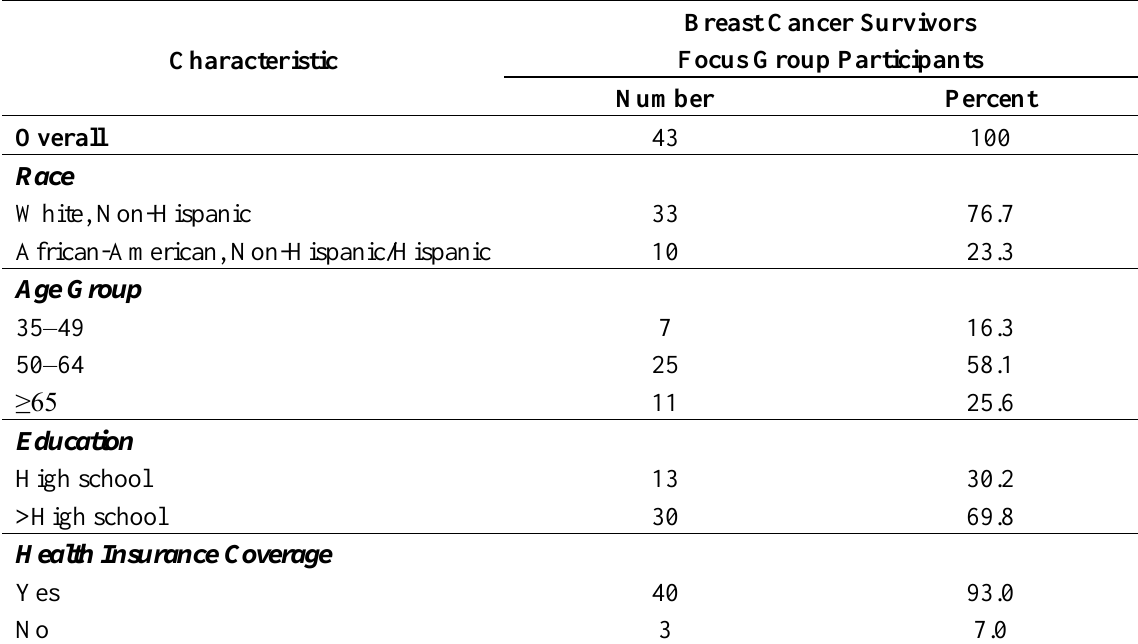
Table 1. Characteristics of female breast cancer survivors participating in the colorectal cancer prevention and screening Power of Prevention focus groups, Missouri, 2011.